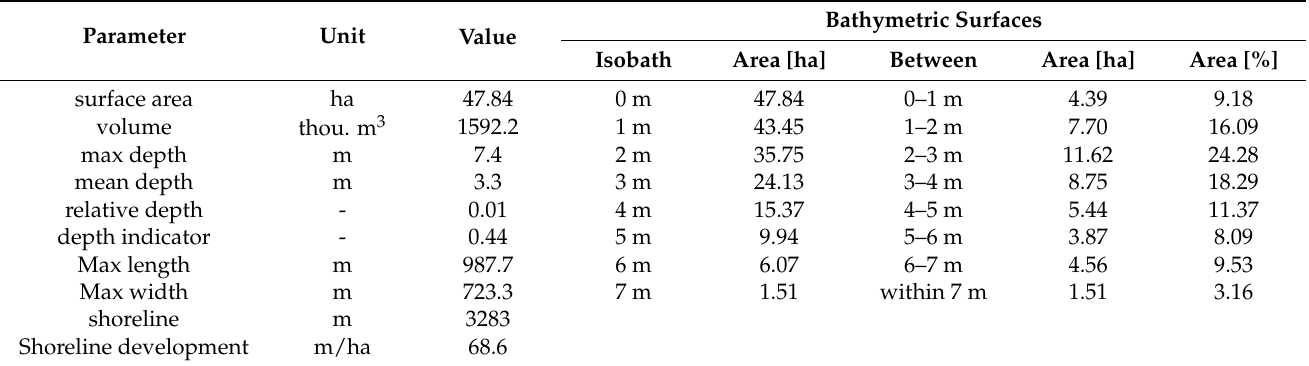
Table 1. Basic morphometric indicators of Lake Łajskie, based on contemporary measurements